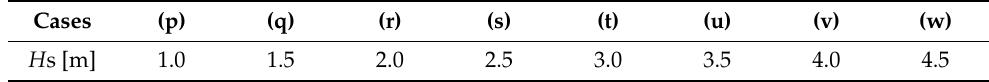
Table 6. Significant wave heights for different cases ( T p: 8.07, 1/ T p: 0.124). Cases